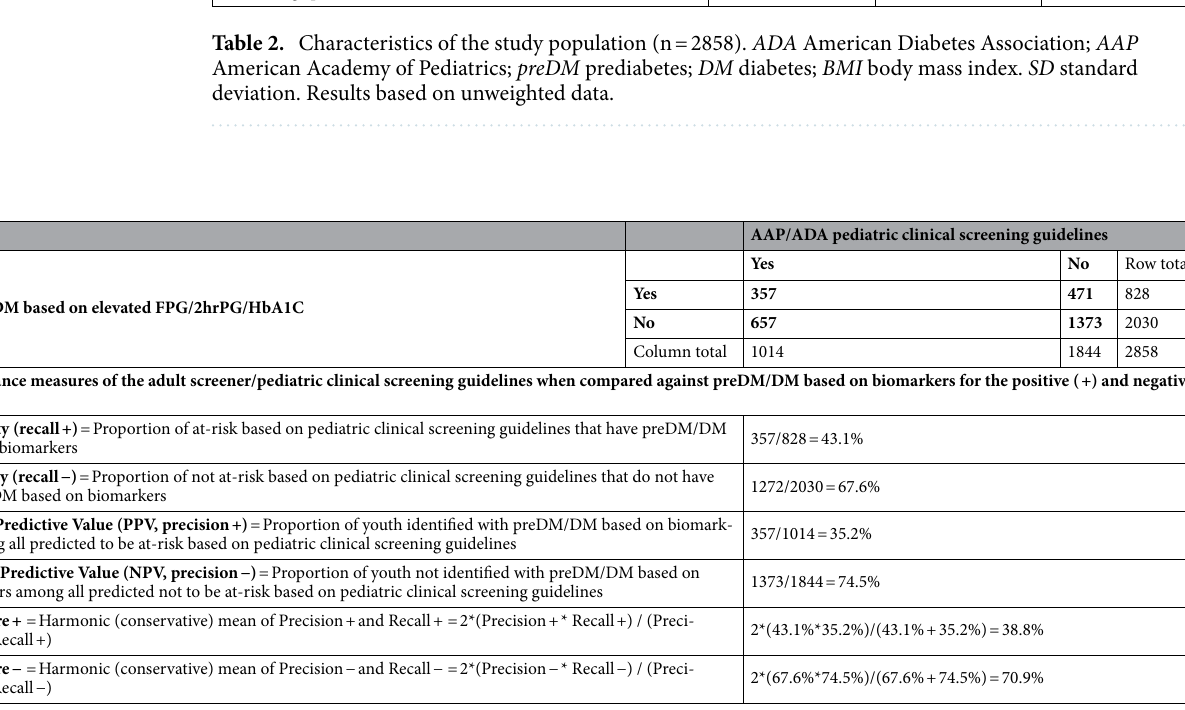
Table 3. Performance measures of pediatric clinical screening guideline when compared against prediabetes/ diabetes (preDM/DM) determinations based on biomarker criteria. ADA American Diabetes Association; AAP American Academy of Pediatrics; preDM prediabetes; DM diabetes; BMI body mass index; FPG fasting plasma glucose; 2hrPG 2 h plasma glucose; HbA1c hemoglobin A1c. Results based on unweighted data.